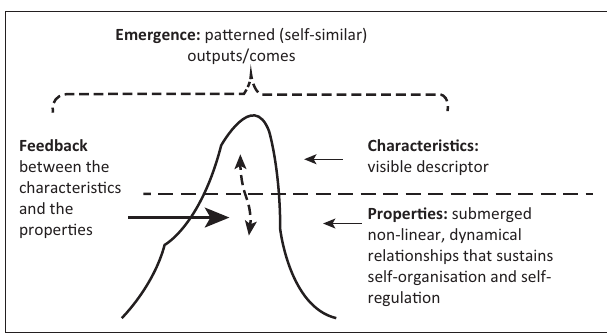
FIGURE 2: The discrete interactions that influence emergence from within complex systems.